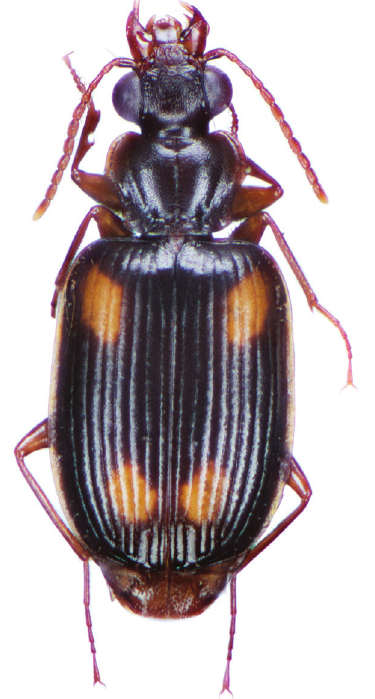
Figure 100. Dorsal habitus and color pattern of Mochtherus tetraspilotus (MacLeay). (OBL 6.48 mm). metric; metepisternum with microsculpture almost isodiametric to isodiametric; other ventral surfaces with microsculpture